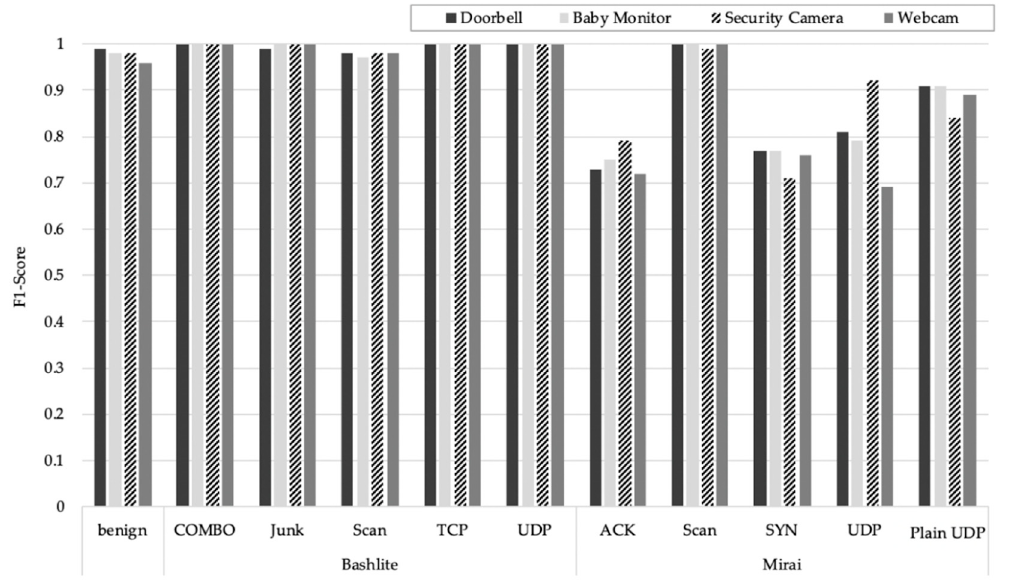
Figure 4. The F1-score of each attack type in the KNN-based model.